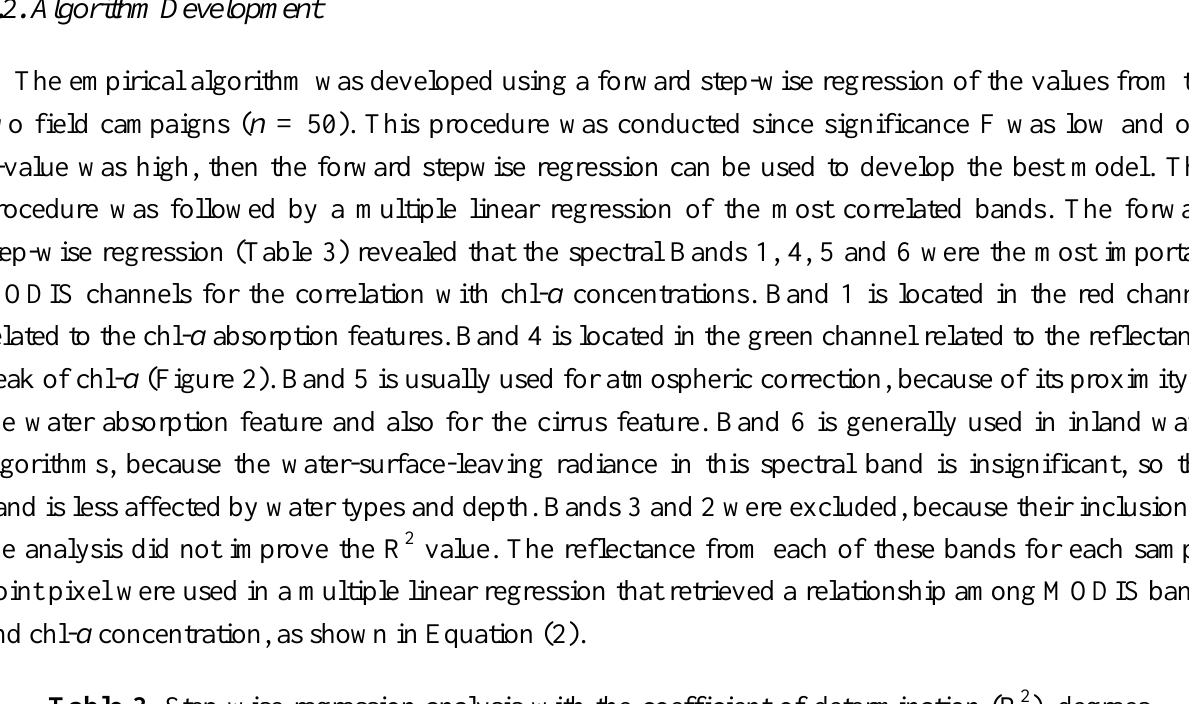
Table 3. Step-wise regression analysis with the coefficient of determination (R 2 ), degrees of freedom (DF), F coefficient (F), variation of R 2 and p